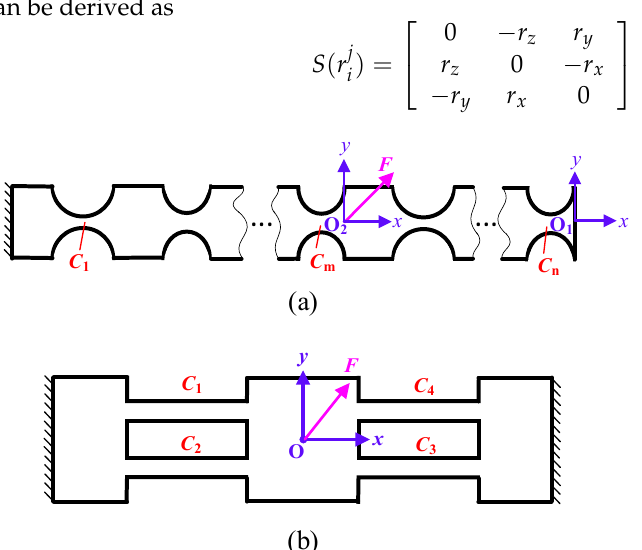
Figure 5. Common serial and parallel flexure hinge mechanisms: ( a ) a series flexure hinge mechanism and ( b ) a typical parallel flexure hinge mechanism.